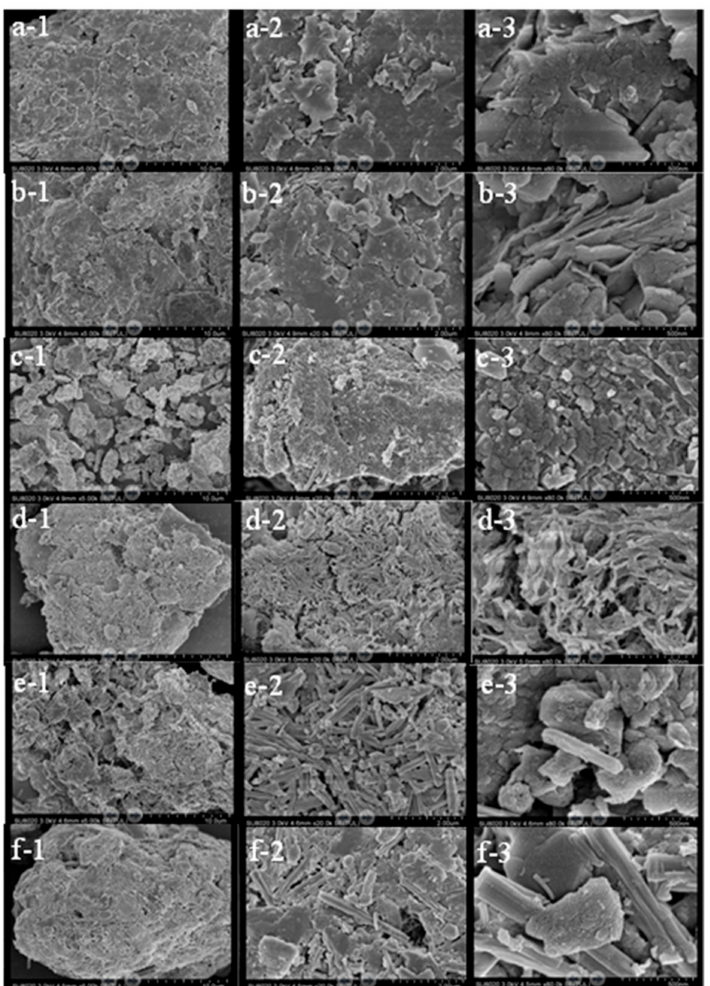
Figure 8. Scanning electron microscopy micrographs of an untreated sample and solidified matrices after seven days of curing: ( a ) untreated, ( b ) CK, ( c ) QL (30%), ( d ) QL (30%) + PS, ( e ) PC (30%), ( f ) PC (30%) + PS; ( 1 ) × 5,000, ( 2 ) × 20,000, ( 3 ) × 80,000. No amendments added (CK); Persulfate (PS); Quick lime (QL), Portland cement